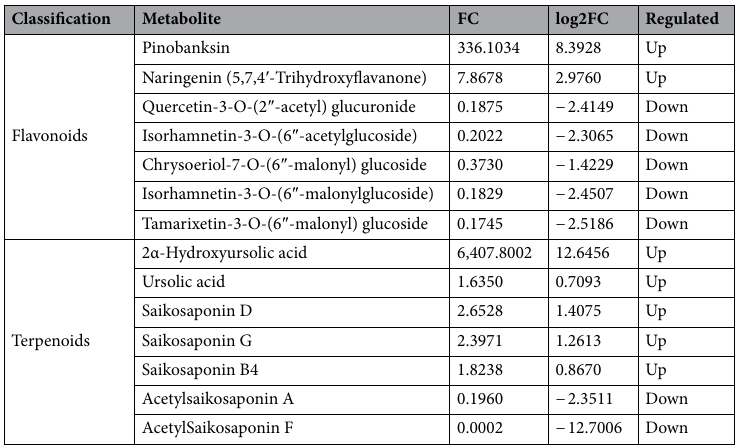
Table 2. Intraspecific differential metabolites (flavonoids and terpenoids) from B. chinense. (BCYC vs. BCZC; The parameters used to select differential compounds were FC > 1, P -value < 0.05 and VIP >